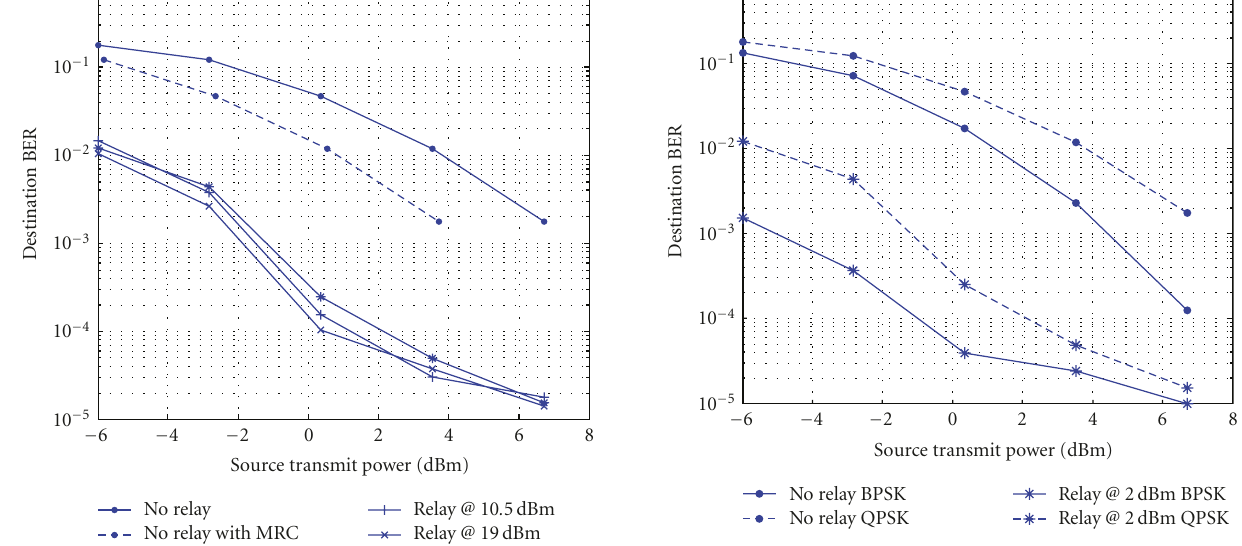
Figure 10: BER results for BPSK and QPSK